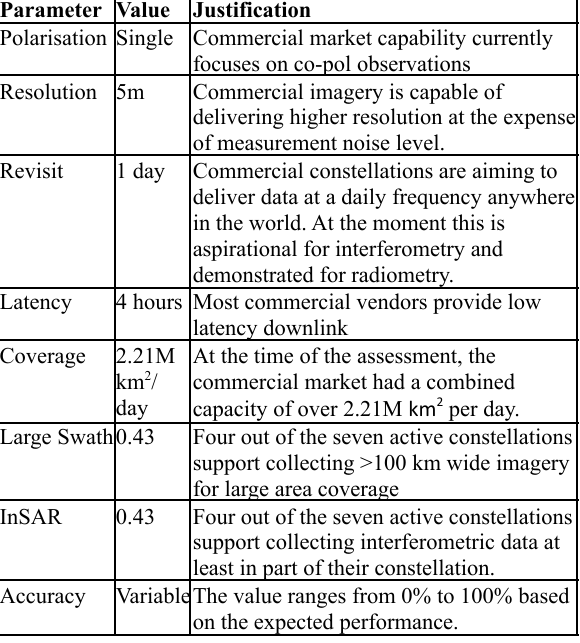
Table 2 . An overview of currently available representative commercial capabilities used in the commercial SAR feasibility estimation